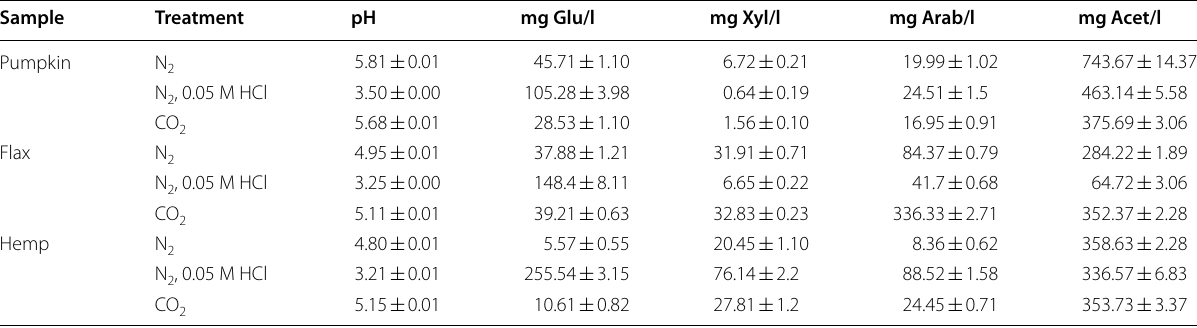
Data represent mean values (n Glu glucose; Xyl xylose; Arab arabinose; Acet acetic acid